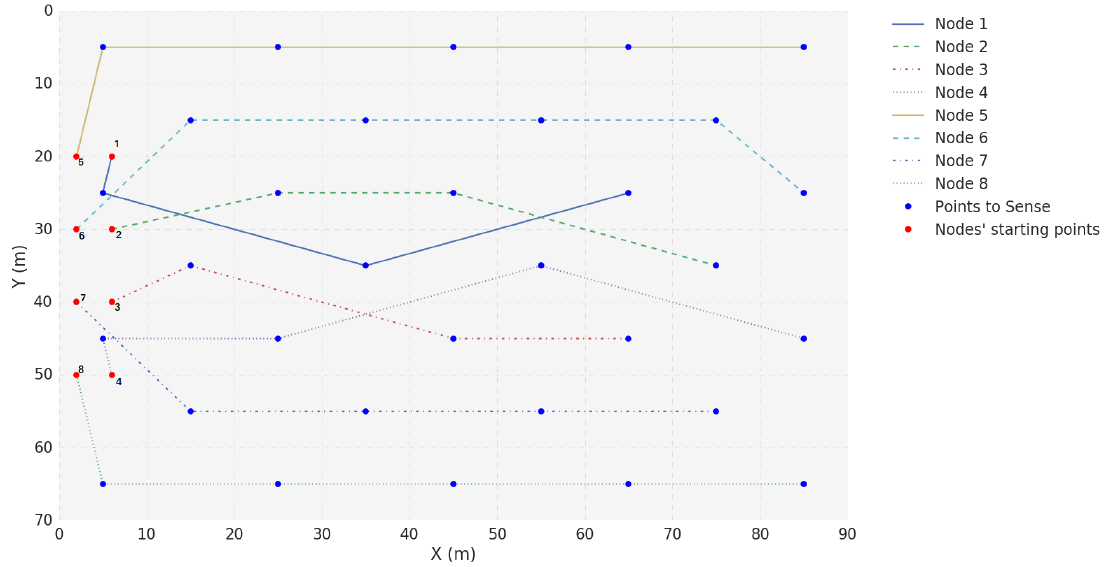
Figure 15. Position progress of each USV in Scenario D.